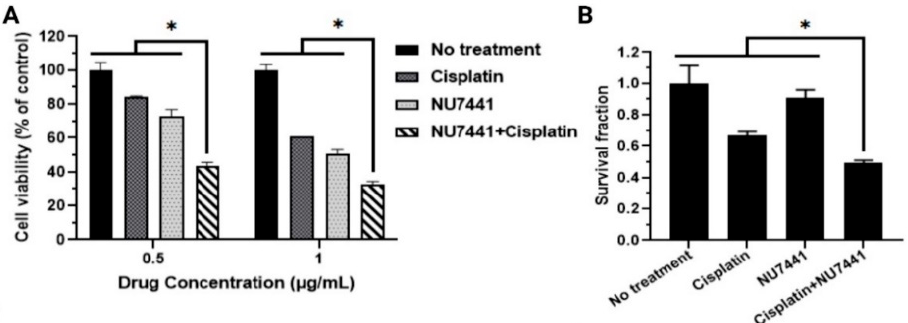
Figure 3. In vitro investigation of dual-drug treatment. ( A ) A549 cell viability via MTS assays after 72 h treatment with drug combinations observed significant decline compared to free drugs. ( B ) Treatment of A549 lung cancer cells with individual free drug vs. combined free drugs revealed lower cancer colony survival in the CFA study as a result of the combined treatment than that with the individual drugs. (* Statistically significant with p < 0.05).